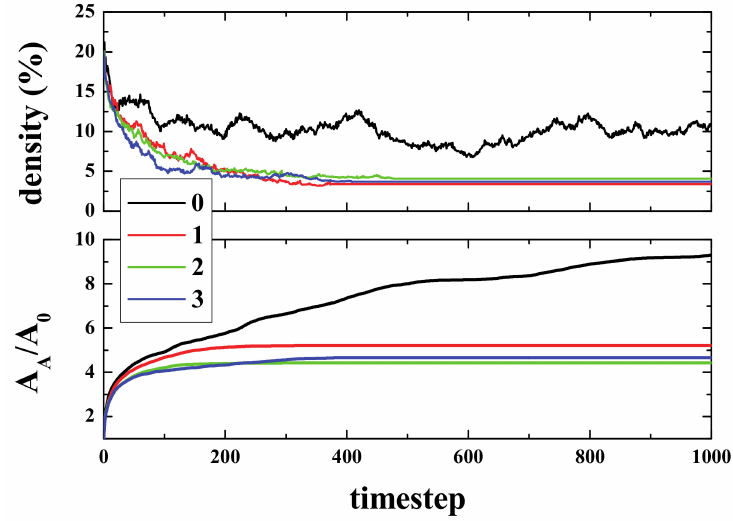
Figure 13. (Color online) Density (top panel) and Active Area, A A , divided by initial area A 0 (bottom panel) vs. time for four different simulations adding randomly distributed defects to the lattice, from 0% to 3% as labelled.